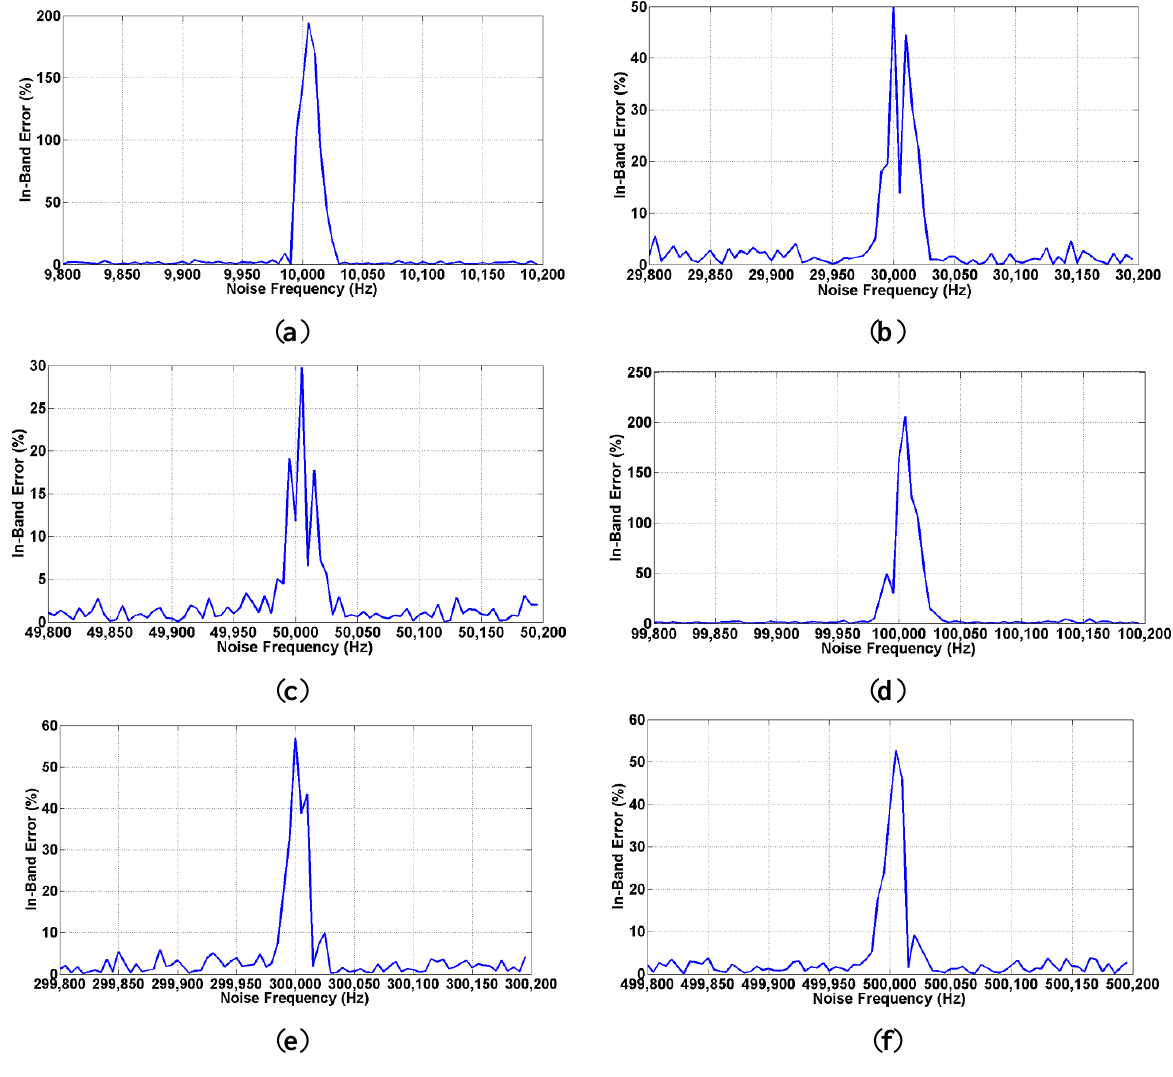
Figure 12. Amplitude recovery for the test signal of 10 mV rms_no at an operating range of 10 kHz ( a – c ) and 100 kHz ( d – f ) in 5 Hz steps buried in −20 dB of sinusoidal interference whose frequency is around the main frequency components of the square data signals.